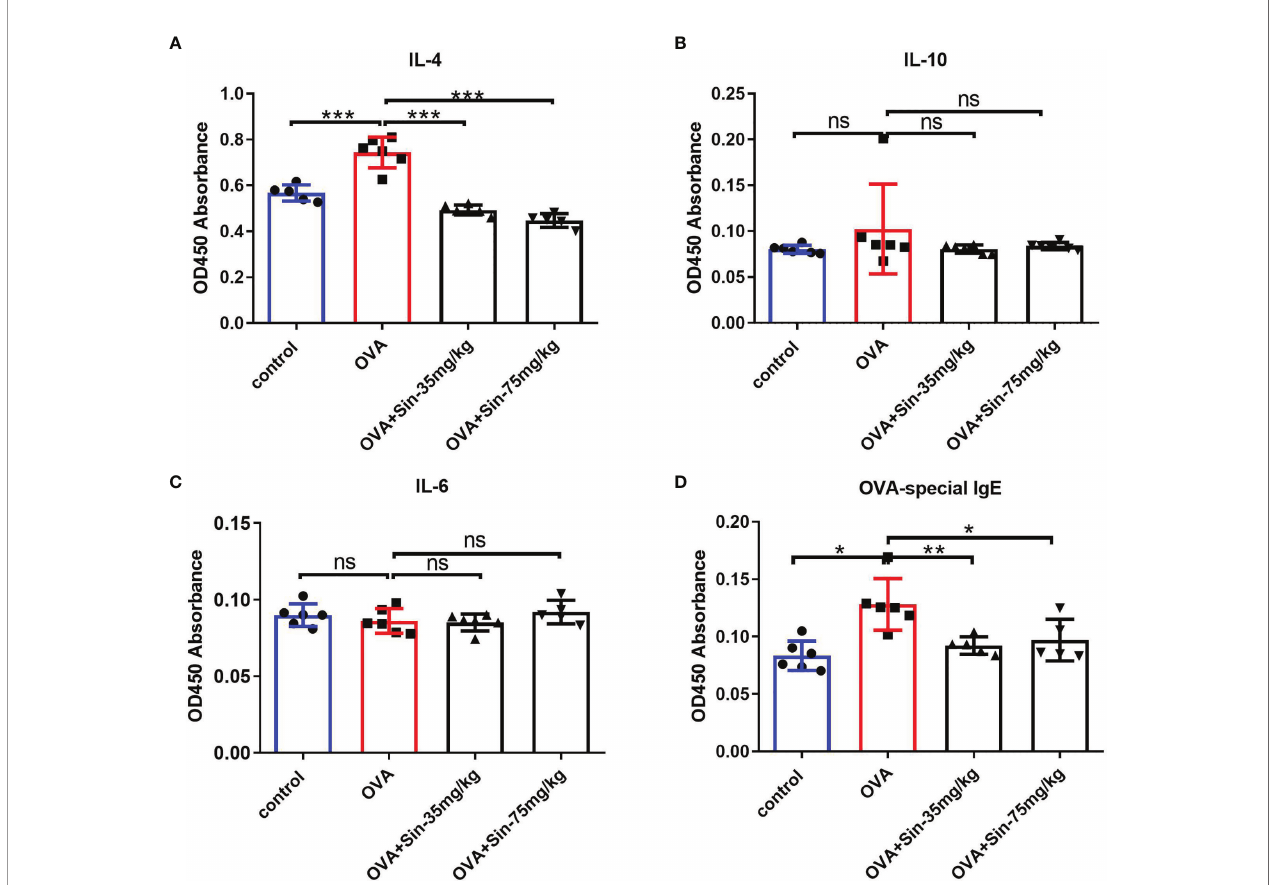
FIGURE 3 | Sin relieved Th2 airway in fl ammation in mice with OVA-induced asthma. (A – C) . IL-4, IL-6, and IL-10 expressions in serum were detected using ELISA on mice from control, model, and Sin-treated (35 mg/kg or 75 mg/kg) groups. OD450 absorbances are shown in the Y-axis. (D) OVA-speci fi c IgE in the serum was detected using ELISA in the abovementioned group. The data are presented as mean ± SEM (n=5-6/group). The one-way analysis of variance followed by Dunnett ’ s Multiple Comparison Test was used. *p < 0.05. **p < 0.01. ***p < 0.001. ns, no signi fi cant difference between the two